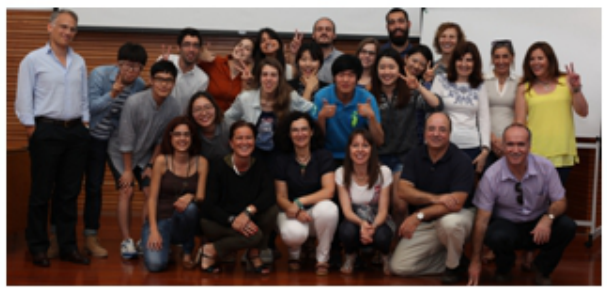
Figure 10. E4SD: The final